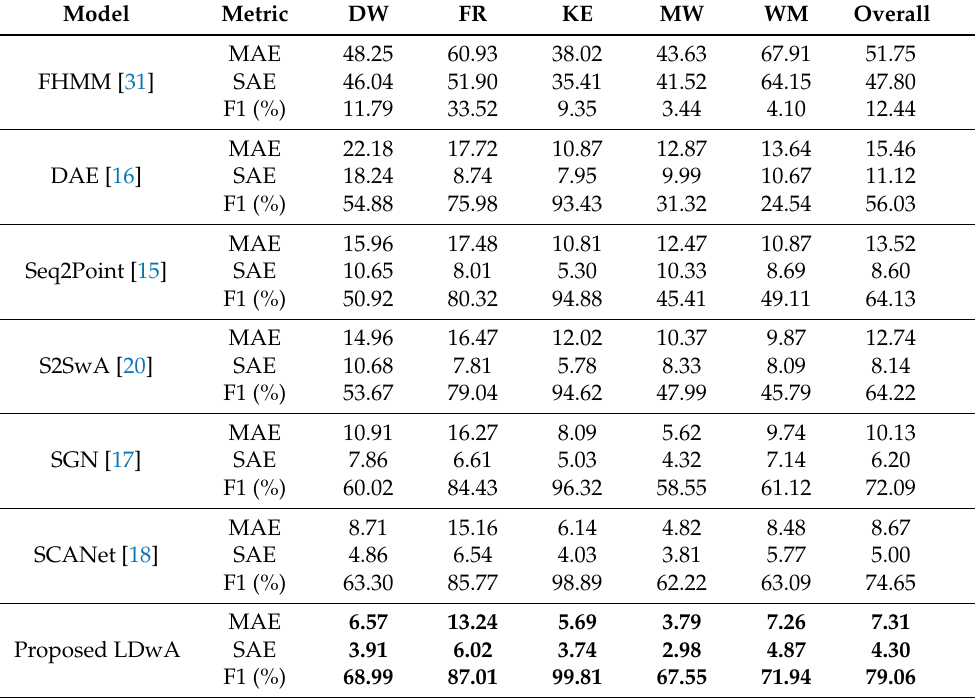
Table 3. Disaggregation performance for the UK-DALE dataset. We report in boldface the best ap- proach.